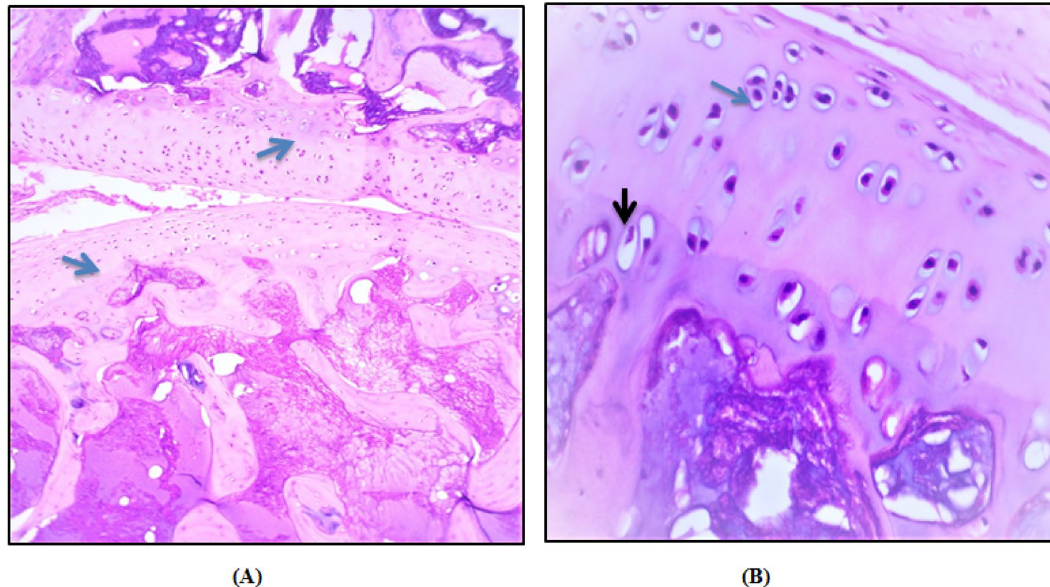
Figure 8. Photomicrographs illustrating the normal microscopic features of sections of articular cartilage of the adult rat. ( A ) Articular cartilage of proximal portion of the tibia the distal portion of the femur is separated into calcified and noncalcified region by a basophilic tidemark (blue arrow). Magnification × 10. ( B ) Chondrocytes lying centrally within its lacunae with centrally located nuclei (blue arrow) and hypertrophic chondrocytes (black arrow) are located in the calcified cartilage near the subchondral bone. Magnification × 40.